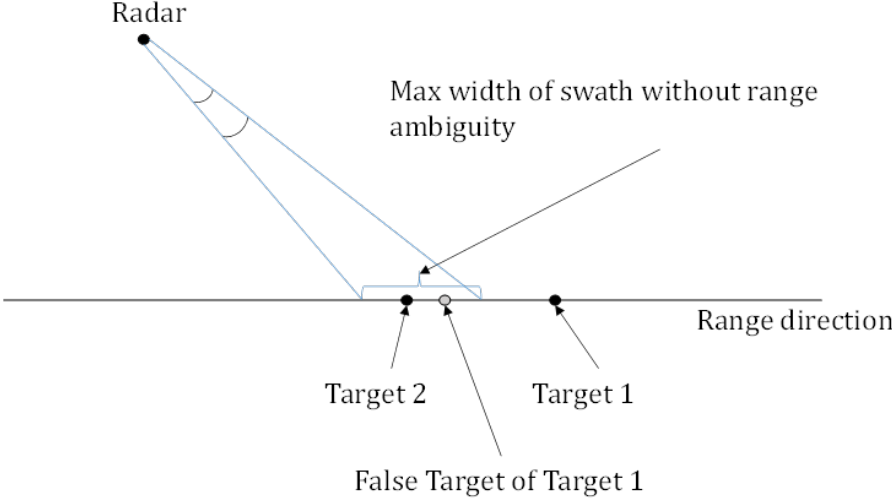
Figure 6. Principle of suppressing the range ambiguity.